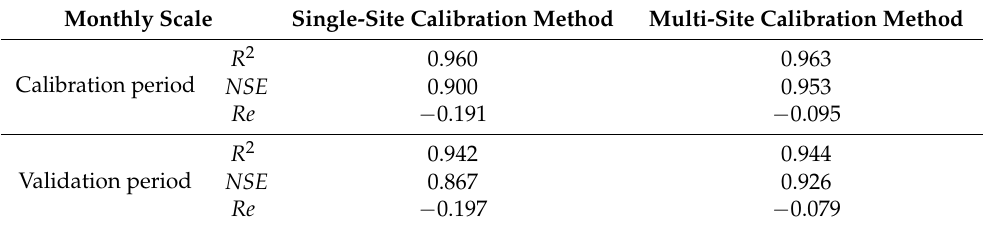
Table 5. Values of evaluation indicators of monthly simulated runoff with different calibration methods. Monthly Scale